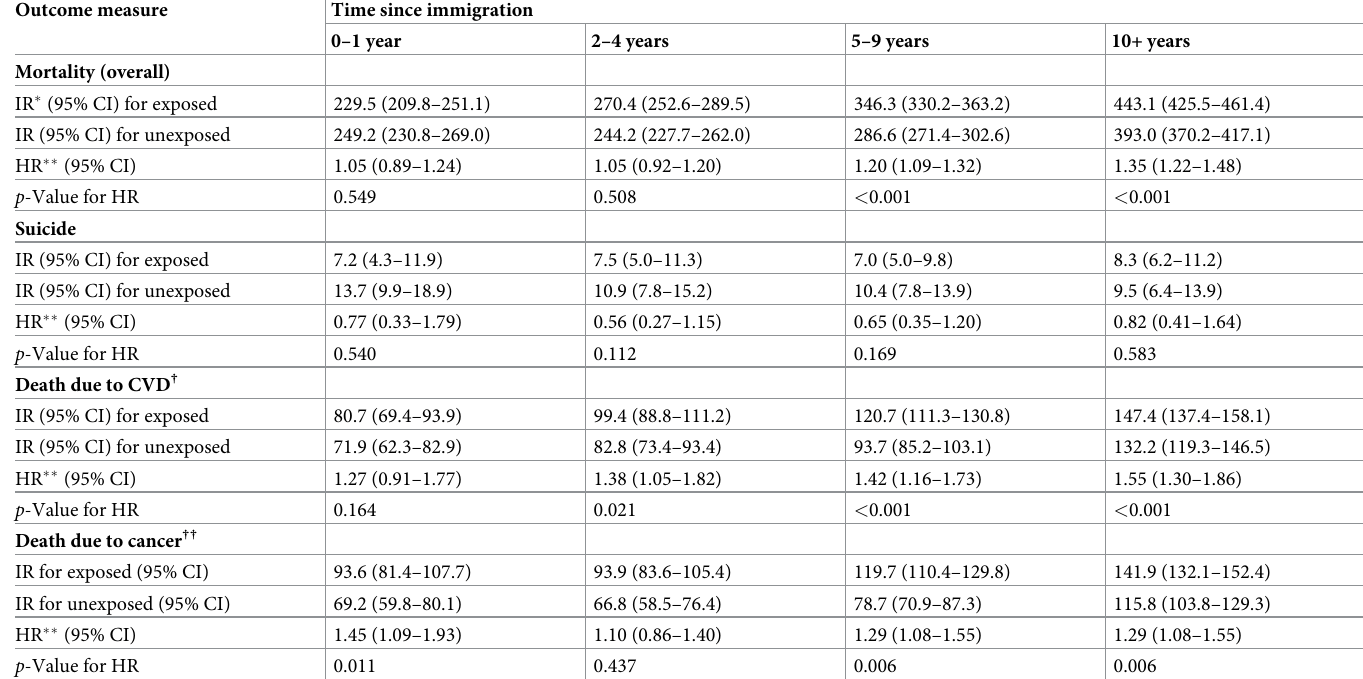
Table 3. Mortality rates in migrants of the Balkan wars (exposed) compared to other European migrants (unexposed), by time since immigration. Outcome